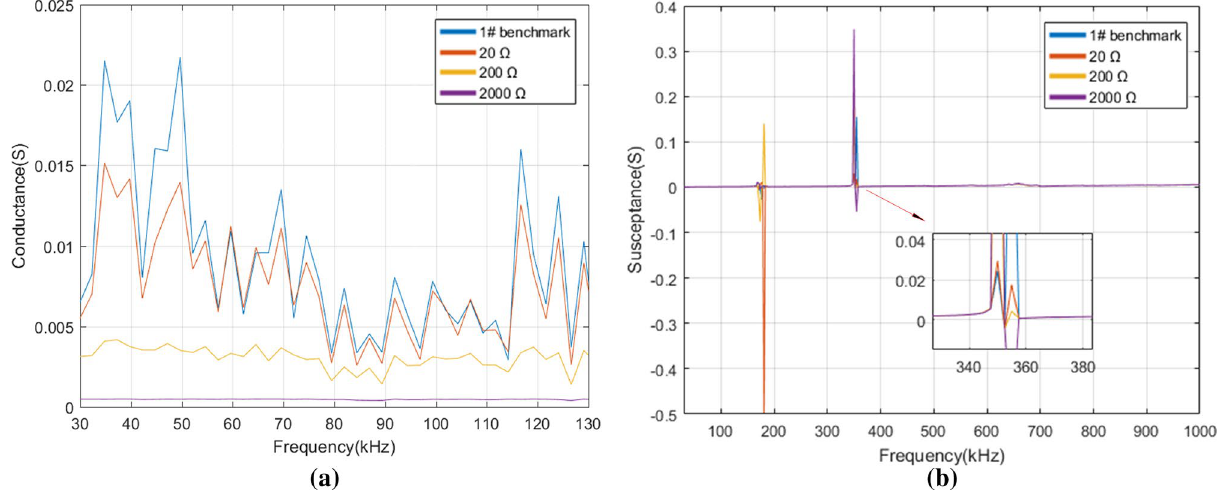
Figure 8. ( a ) The conductance and ( b ) the susceptance of 1# PZT under healthy and different pseudo soldering conditions.